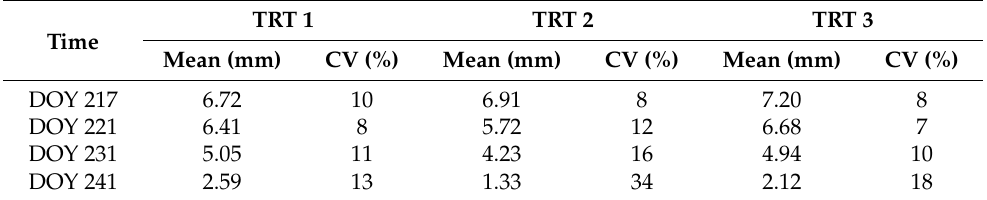
Figure 9. Maize evapotranspiration maps retrieved by combining CWSI-TCARI / RDVI (Equation (14) and (15)) and Kcb-NDVI (Equation (10) and (11)) regression models. ( a ) and ( b ) are evapotranspiration maps for the reproductive (DOY 217 and DOY221) stages. ( c ) and ( d ) are the evapotranspiration maps for the maturation (DOY231 and DOY241) stages. Table 4. Coefficient of variation (CV; %) and mean ET over each sample area under different water treatments on DOY 217, 221, 231, and 241.